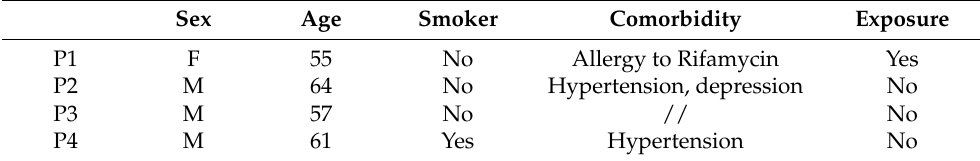
Table 1. Comorbidities and demographics of study population.